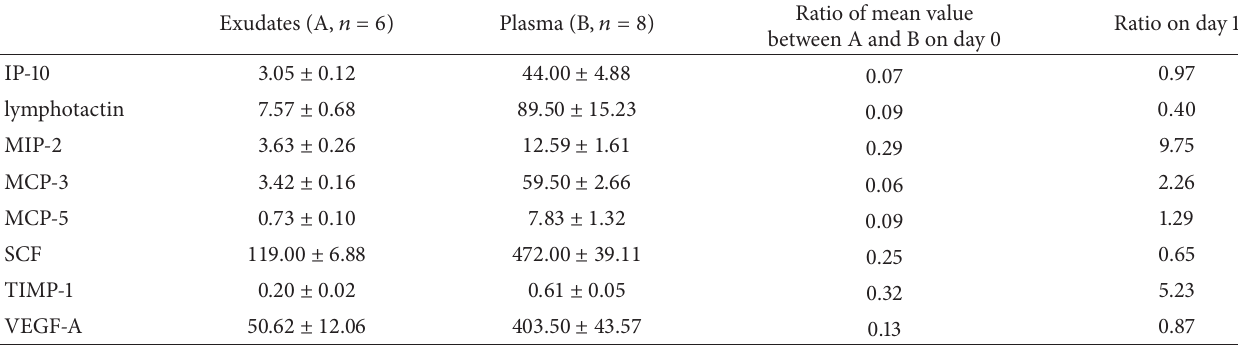
Table 2: Concentrations of inflammatory mediators in exudates and plasma at basal condition in vivo.